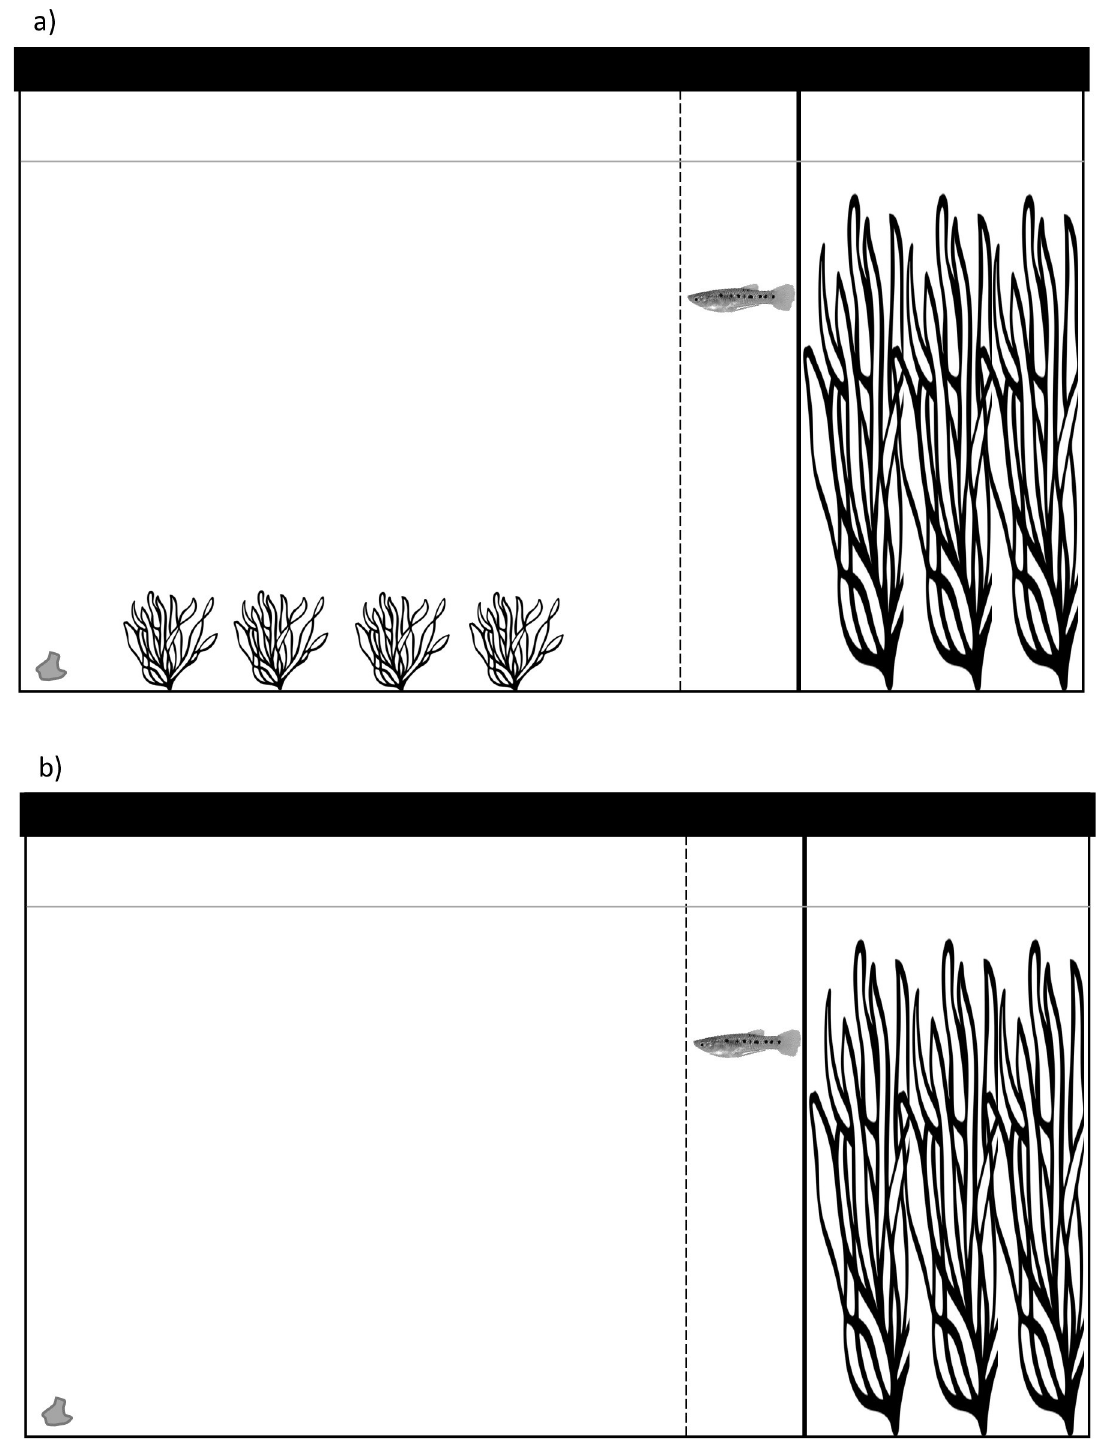
Fig 1. a) Diagram of the complex habitat: this habitat had a refuge built with 20cm tall plants (right), and 4cm tall plastic plants outside of the refuge (left). Two lines marked in the crystal designated the “refuge line” (a solid line, adjacent to the refuge) and the “starting line” (towards the 4cm plants). A food flake was submerged on the far end of the tank from the refuge (far left). b) Diagram of the simple habitat: this habitat had only a refuge (right) built with 20 cm tall plants, two lines marked in the crystal designated the “refuge line” (a solid line, adjacent to the refuge) and the “starting line” between the refuge line and the open area), and a food flake submerged (far left).